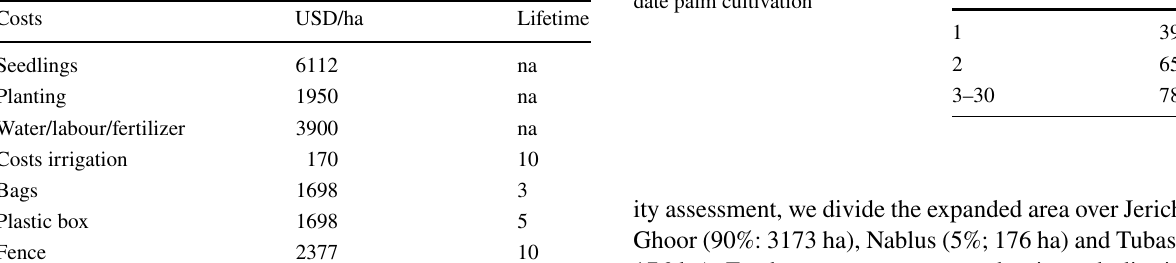
Table 9 Recurring costs for date palm